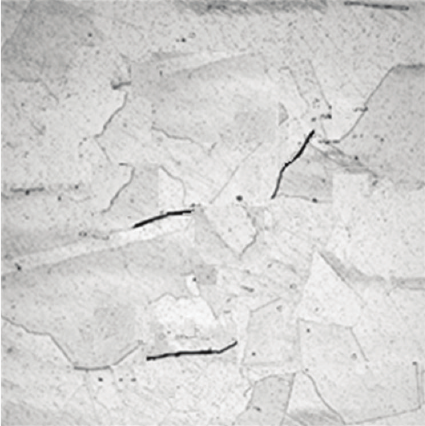
Figure 7: Austenitic stainless steel type 316NH (80 𝜇 m) showing hair line cracks and no pits.